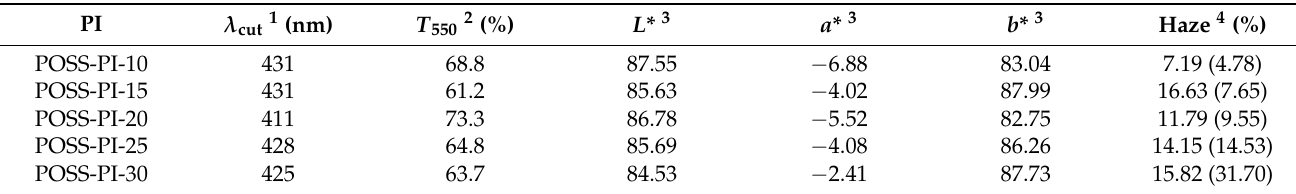
Table 2. Optical properties of POSS-PI composite